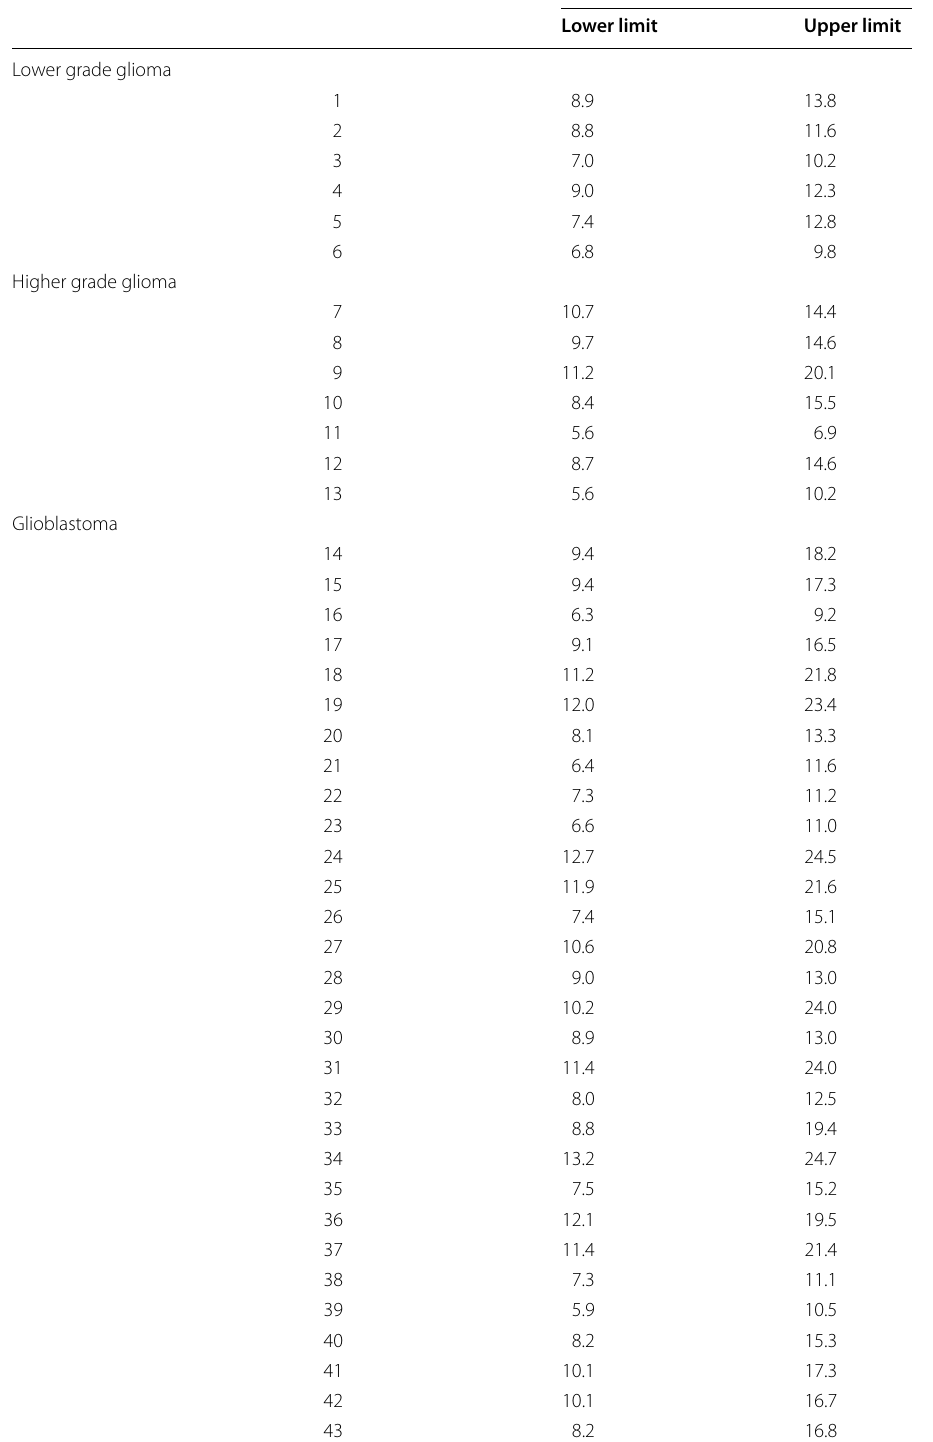
Lower limit Upper limit